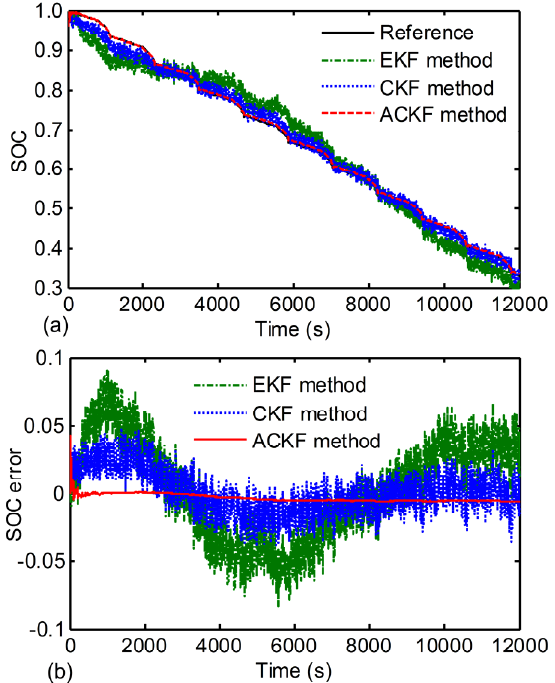
Figure 13. SOC estimation results with voltage noise under NEDC test: ( a ) SOC; ( b ) SOC